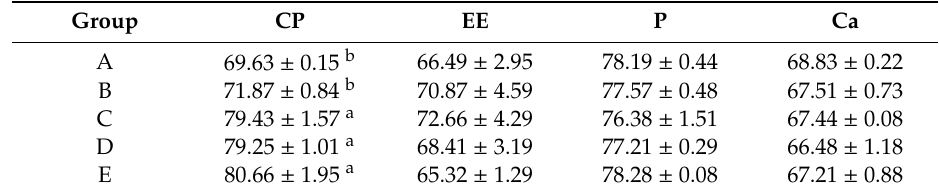
Table 3. E ff ect of CPB on piglet nutrient digestibility